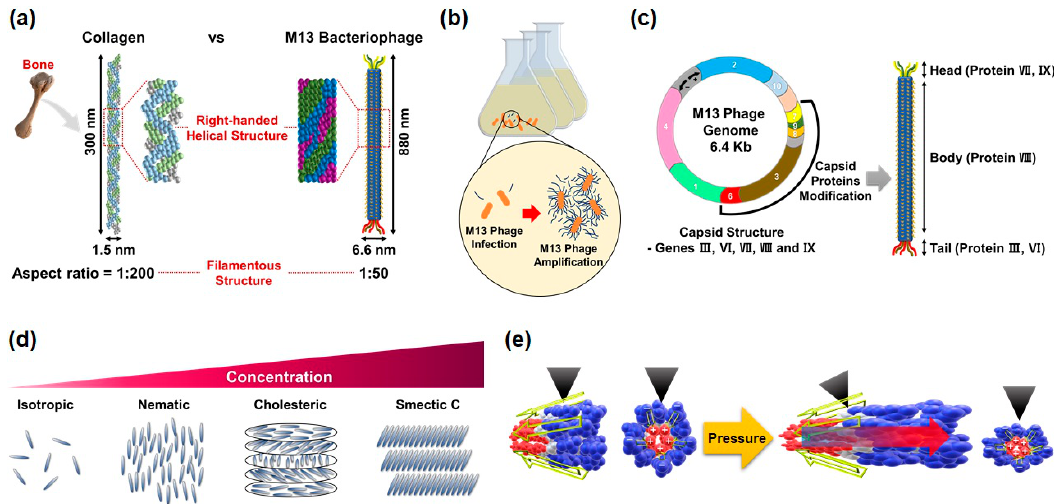
Figure 1. Schematic diagram showing the main characteristics of M13 bacteriophages (phages). ( a ) Structural similarity between natural collagen and M13 phages. Both biomaterials are filamentous structures with high aspect ratio and have right-handed helical structures. ( b ) Infection and mass-amplification of M13 phages. A huge amount of phages can be produced in infected bacteria by using the metabolic reactions of the host cell. ( c ) M13mp phage vector and surface modification through genetic engineering. We can design the molecular structures of the phage’s outer surfaces in accordance with the desired properties and display the related peptide motif on the coat proteins of M13 phages. ( d ) Liquid crystalline phase transition of M13 phages. M13 phages exhibit a lyotropic liquid crystalline phase transition due to their helical structure, nanofibrous shape, monodispersity, and functional motifs. ( e ) Piezoelectric properties of M13 phages, which enable us to make piezoelectric energy harvesting devices.